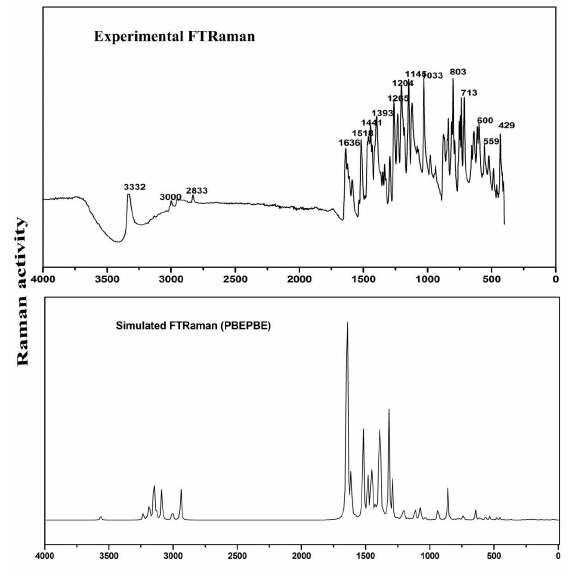
Figure 7: Experimental and simulated (PBEPBE) FR-Raman spectra of